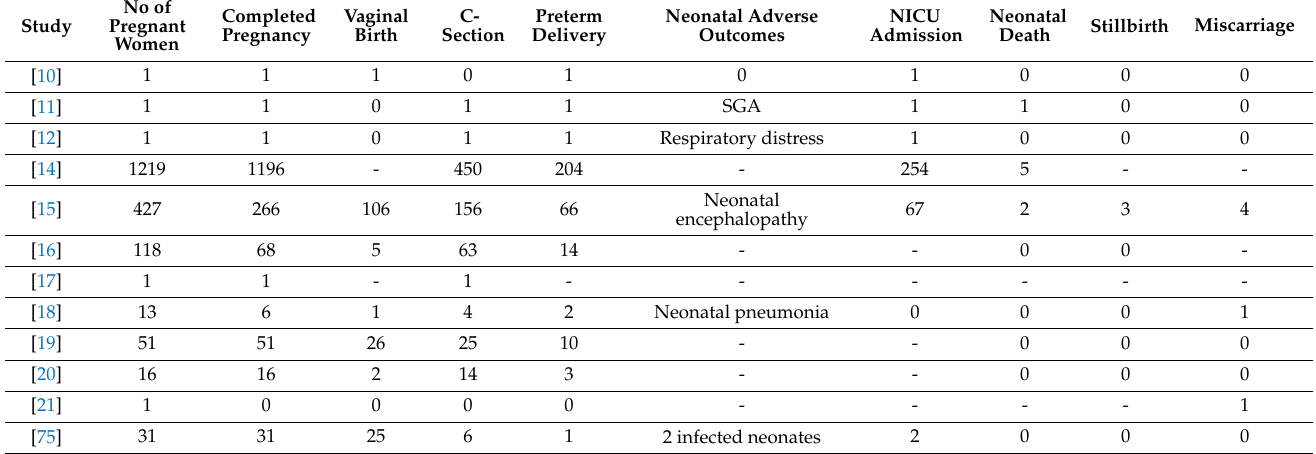
Table 2. An overview of the reported neonatal outcomes in pregnant patients diagnosed with COVID-19 as described in the included